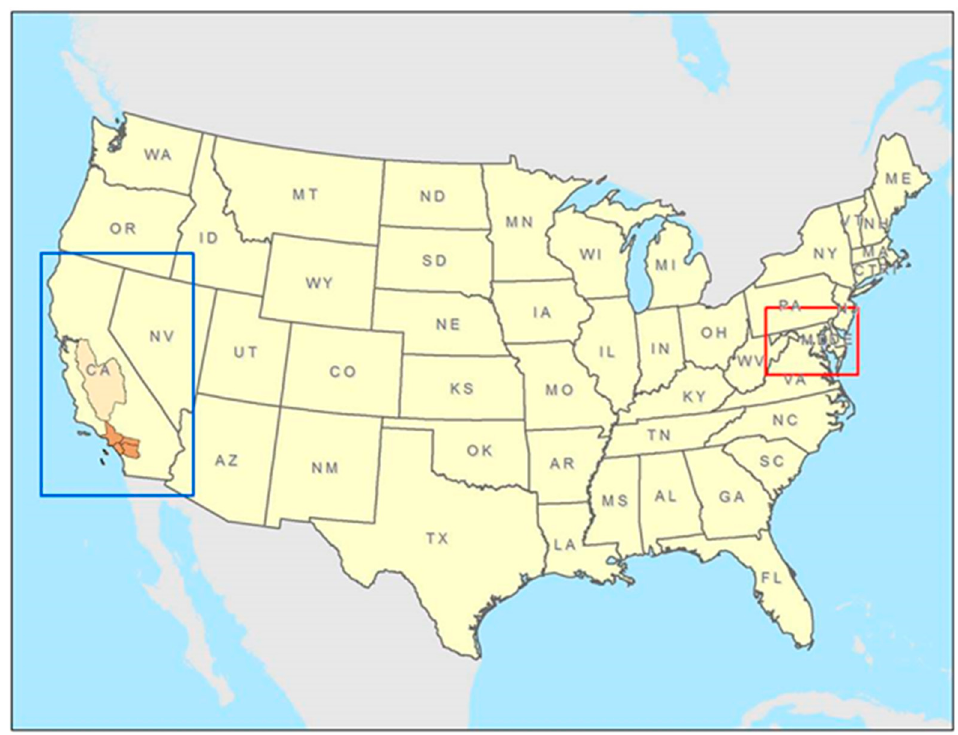
Figure 1. Western (blue outline) and eastern (red outline) subdomains within the 12-km resolution continental U.S. (CONUS) domain.